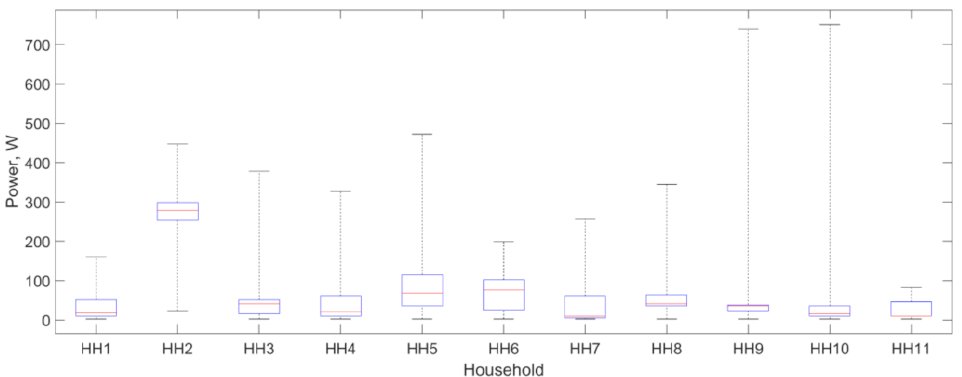
Figure 15. Box plot of power demand in households of the Gilutongan Island solar microgrid based on two months of consumption monitoring data (October and November